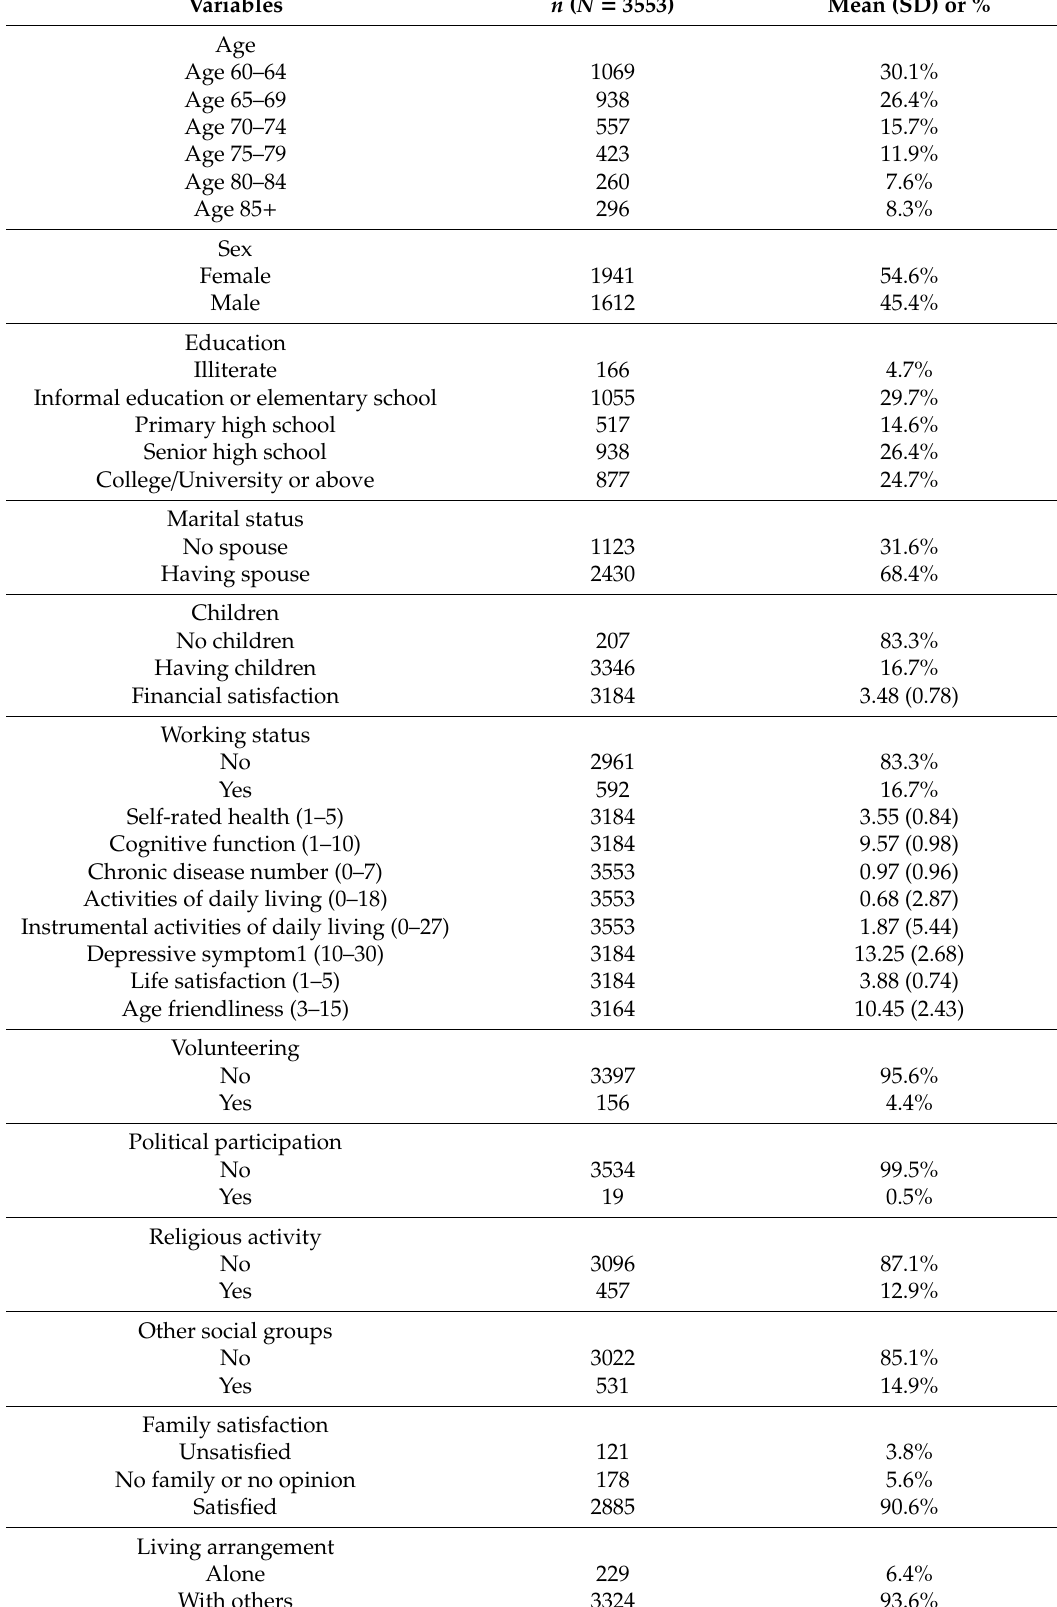
Table 1. Description of the